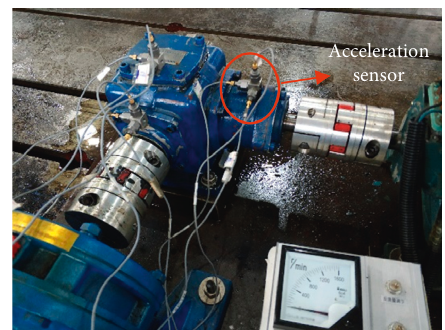
Figure 3: Spiral-bevel gearbox test equipment.